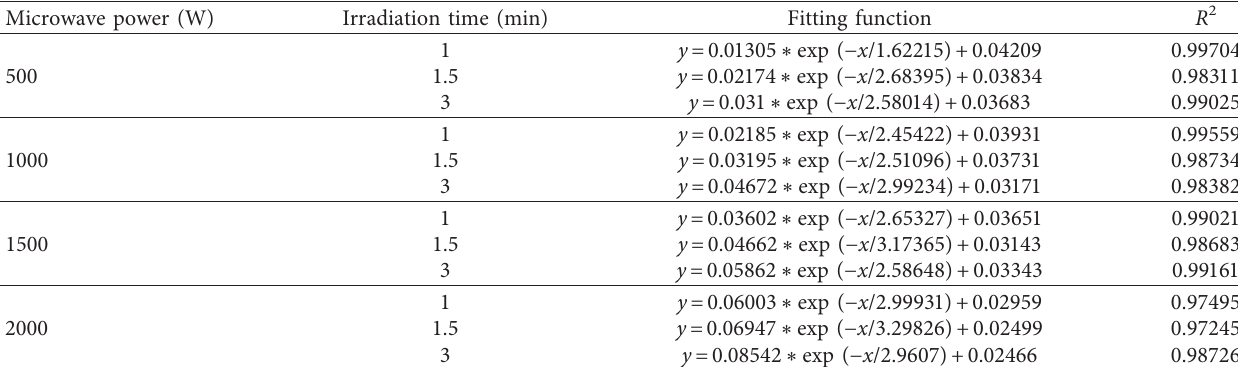
Table 5: Fitting results for permeability under a confining pressure of